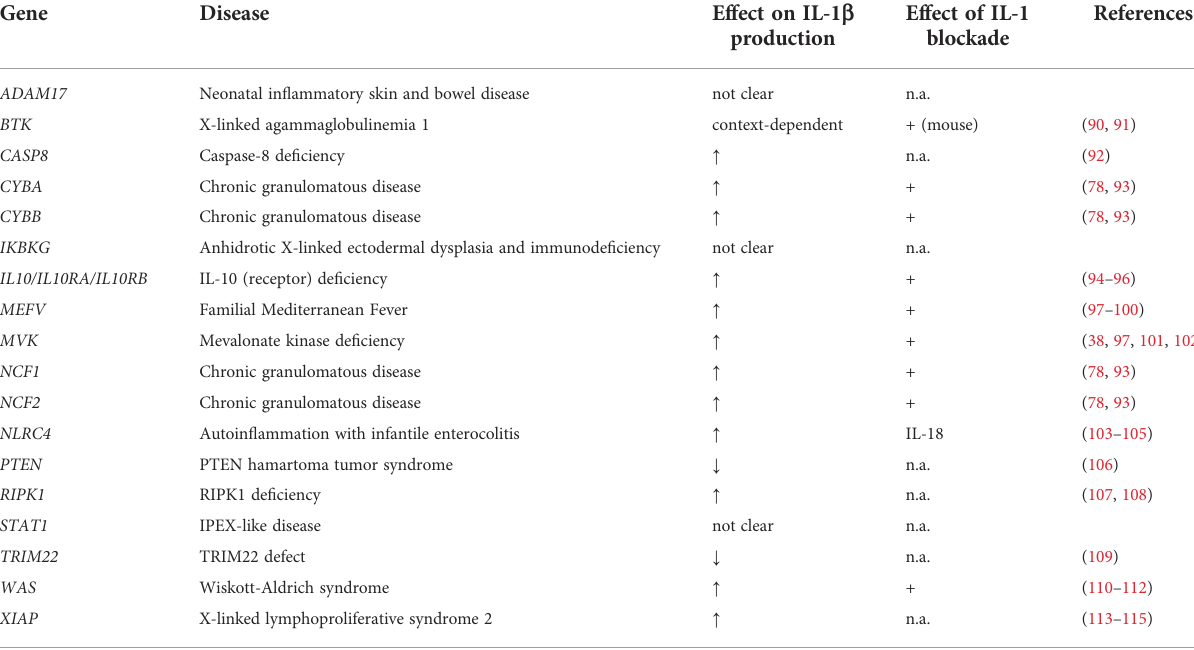
TABLE 1 Overview of monogenic forms of IBD associated with in fl ammasome dysregulation.